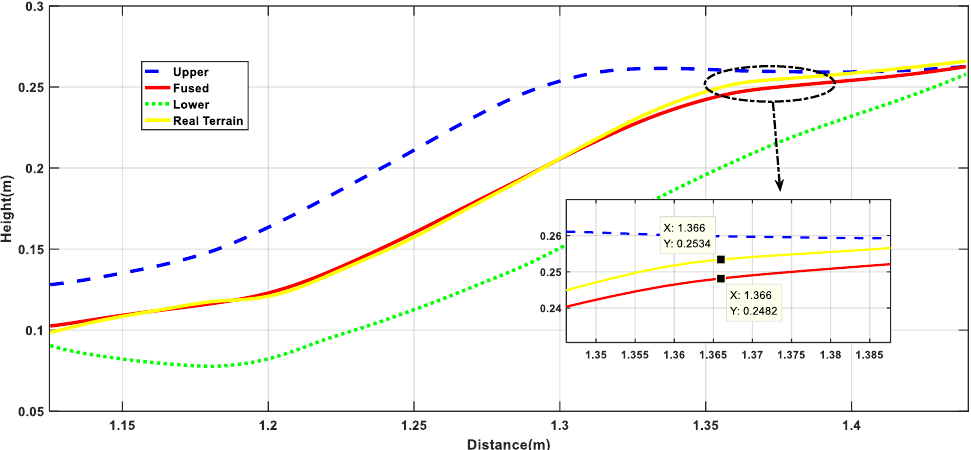
Sensors 2019 , 19 , x